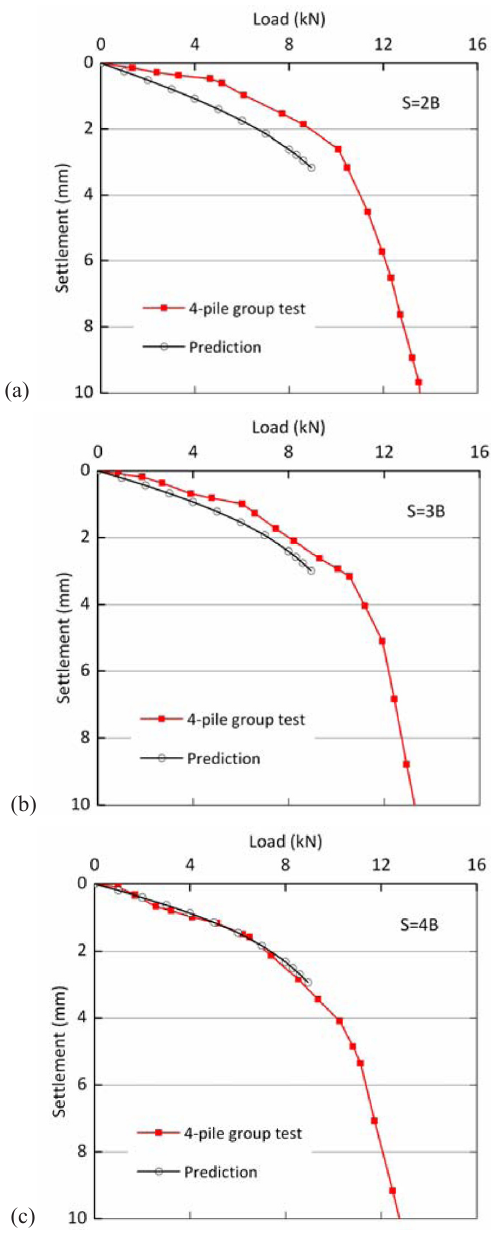
Fig. 21. Predicting 4-pile group behaviour – Groups with different pile spacing: (a) S/B = 2; (b) S/B = 3; (c) S/B = 4